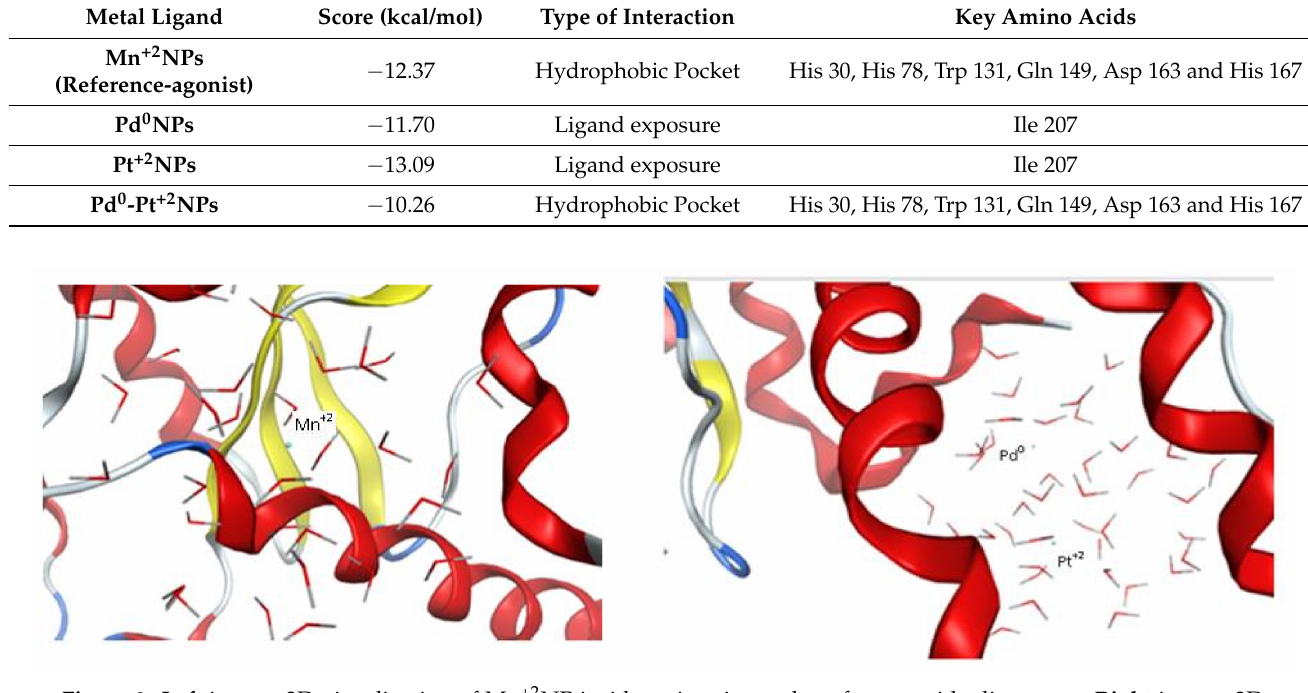
Figure 8. Left image: 3D visualization of Mn +2 NP inside active site pocket of superoxide dismutase. Right image: 3D visualization of Pd 0 -Pt +2 NPs mixture inside the pocket generated by MOEv.2010. The ribbon shape represented the receptor (superoxide dismutase), the lined molecules represented the model surface of the nanoparticles and the solid ball in middle represented the active